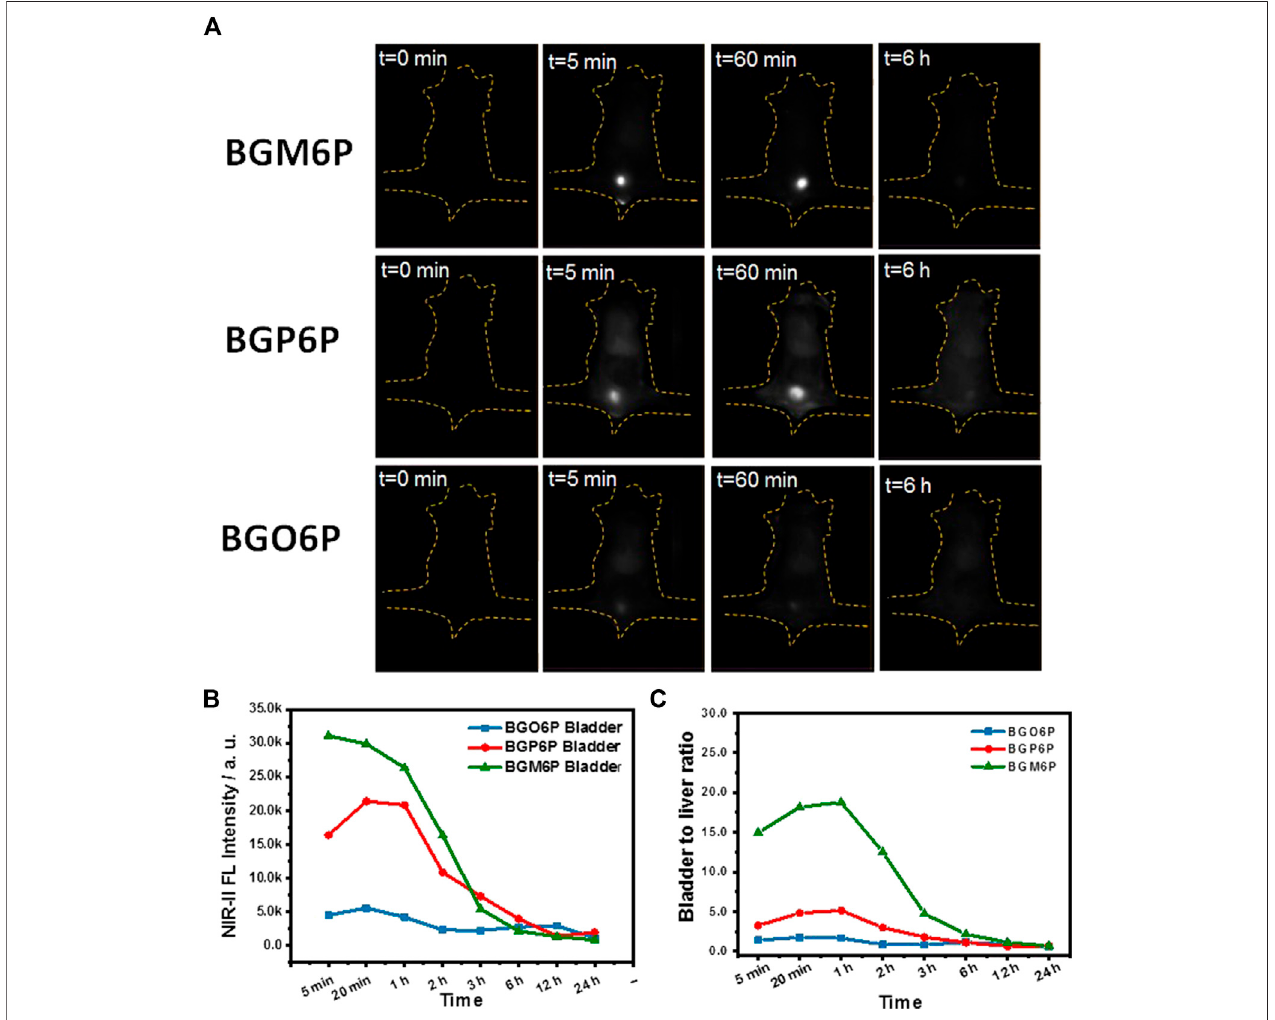
FIGURE 4 | (A) Wide- fi eld fl uorescence imaging of mice injected with BGM6P, BGP6P and BGO6P as function of time. (B) The real-time NIR-II fl uorescence intensity in bladder for BGM6P, BGP6P and BGO6P, respectively (C) Representative background subtracted signal of bladder to liver as a function of time for mice injectedwithBGM6P,BGP6PandBGO6P,respectively.Allthe fl uorescenceimagingwastakenintheNIR-IIwindow (imagingcondition:808 nmlaserexcitation,power density: 60 mW/cm 2 , exposure time: 100 ms, 1,100 nm long pass (LP) fi lter, injection dose: optical density (OD) value (cid:2) 3.4, 200